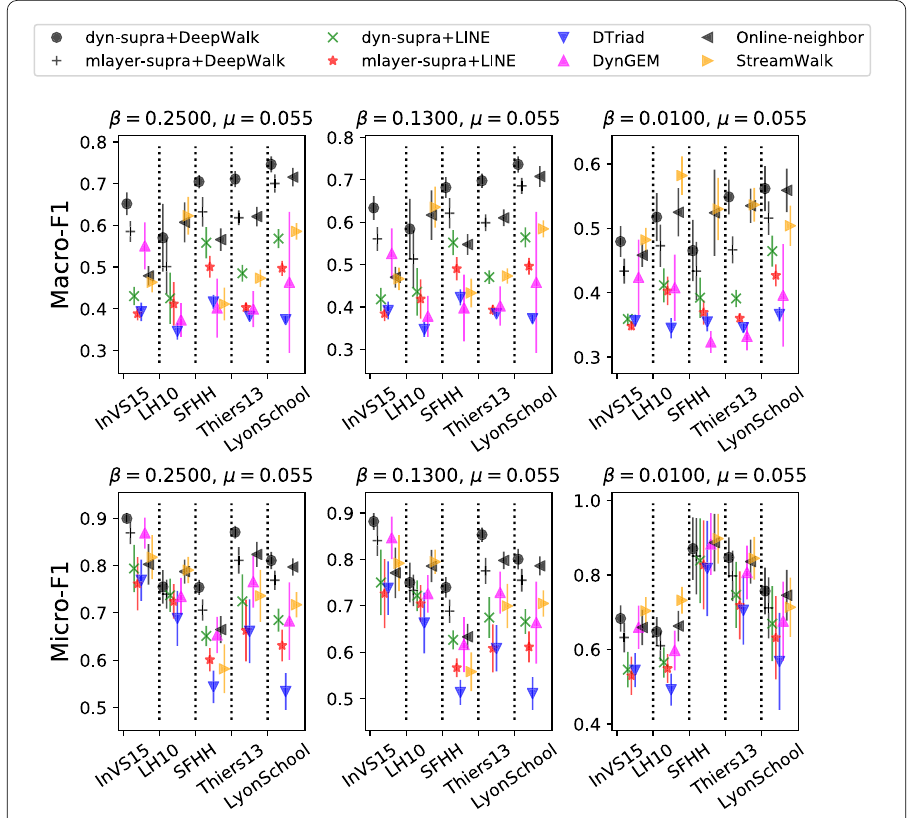
Figure 2 Prediction performance of each method, for each data set and for various β , at fixed μ = 0.055. The results at fixed β and for various μ are shown as a Supplementary Figure. The top and bottom row give the obtained values of Macro-F1 and Micro-F1, respectively. Error bars give the standard deviation computed over the realizations of the SIR process and the embeddings